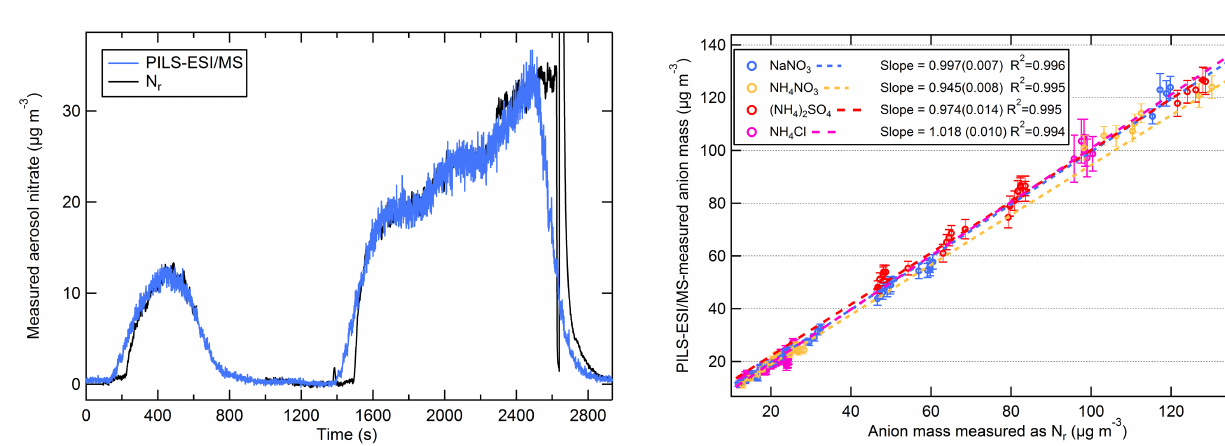
Figure 8. The PILS–ESI/MS-measured aerosol nitrate mass (blue) and the nitrate measured as N r (black) (µgm − 3 ) for an atomized so- lution of NaNO 3 (polydisperse). The PILS–ESI/MS trace is shifted to account for the delayed response and the instrument time con- stant.